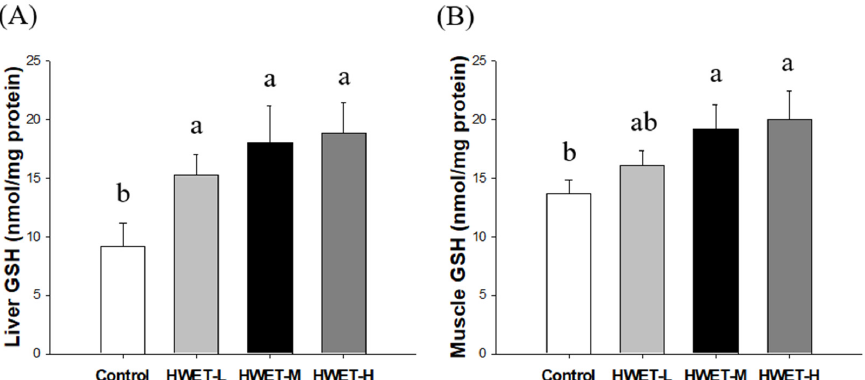
Figure 5. Effects of HWET treatment on GSH content in ( A ) liver and ( B ) muscle of mice after swim- ming endurance test. Mice were treated with vehicle (control), 800 mg/kg (HWET-L), 1600 mg/kg (HWET-M), or 4000 mg/kg (HWET-H) of HWET once per day for 7 days; all mice were euthanized and GSH content in liver and muscle tissues measured 1 h after swimming endurance test. Values are expressed as the mean ± SEM. Different letters indicate statistical difference, p < 0.05.